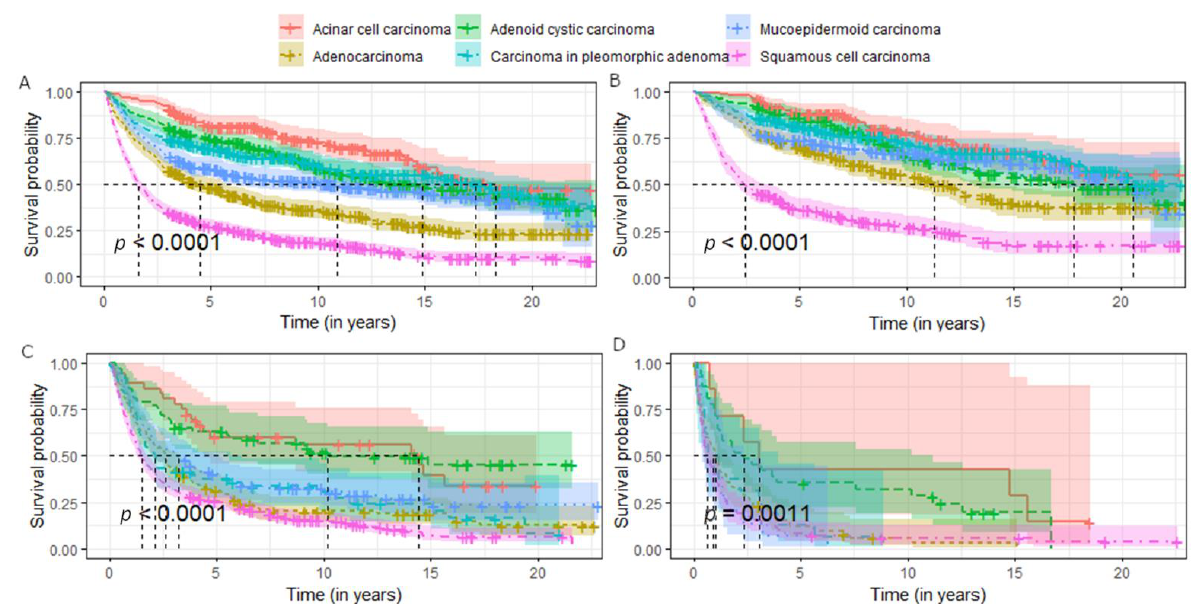
Figure 3. Survival of patients with specified parotid gland cancers stratified by stadium of advance- ment: ( A ) all cancers, ( B )regional stadium, ( C ) locoregional stadium, ( D ) systemic stadium.